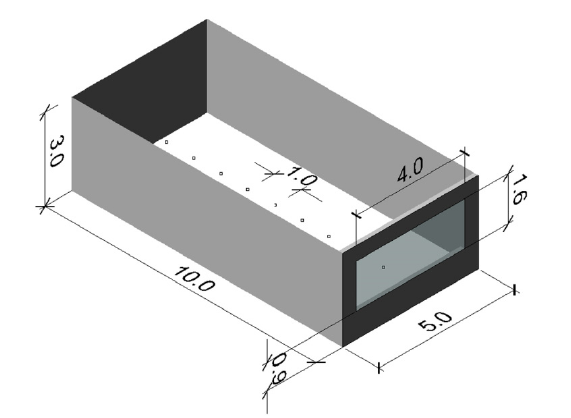
Figure 1. Geometry of the case study and control grid.